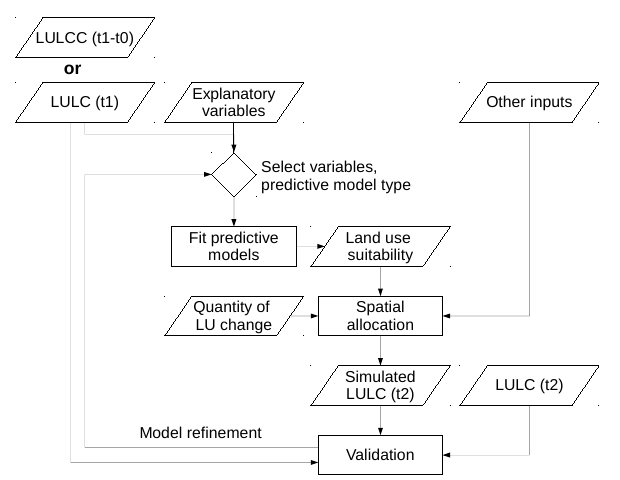
Figure 1. Diagram showing the general methodology used for in- ductive land use change modelling applications, adapted from Mas et al. (2014). The input land use/land cover data can be a single categorical map showing the pattern of land use/land cover at one time point (LULC (t1)) or a series of maps showing historical land use/land cover transitions (LULCC